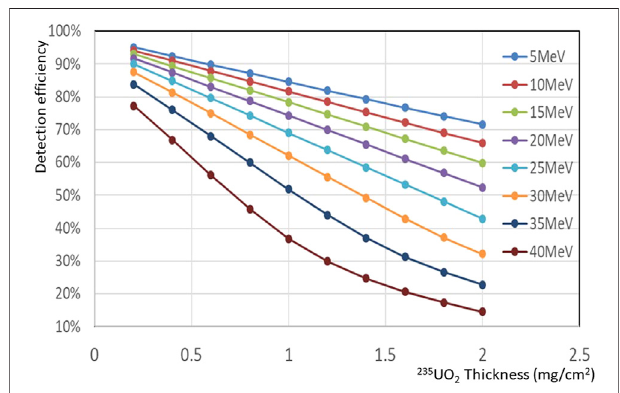
2 targetlayersof